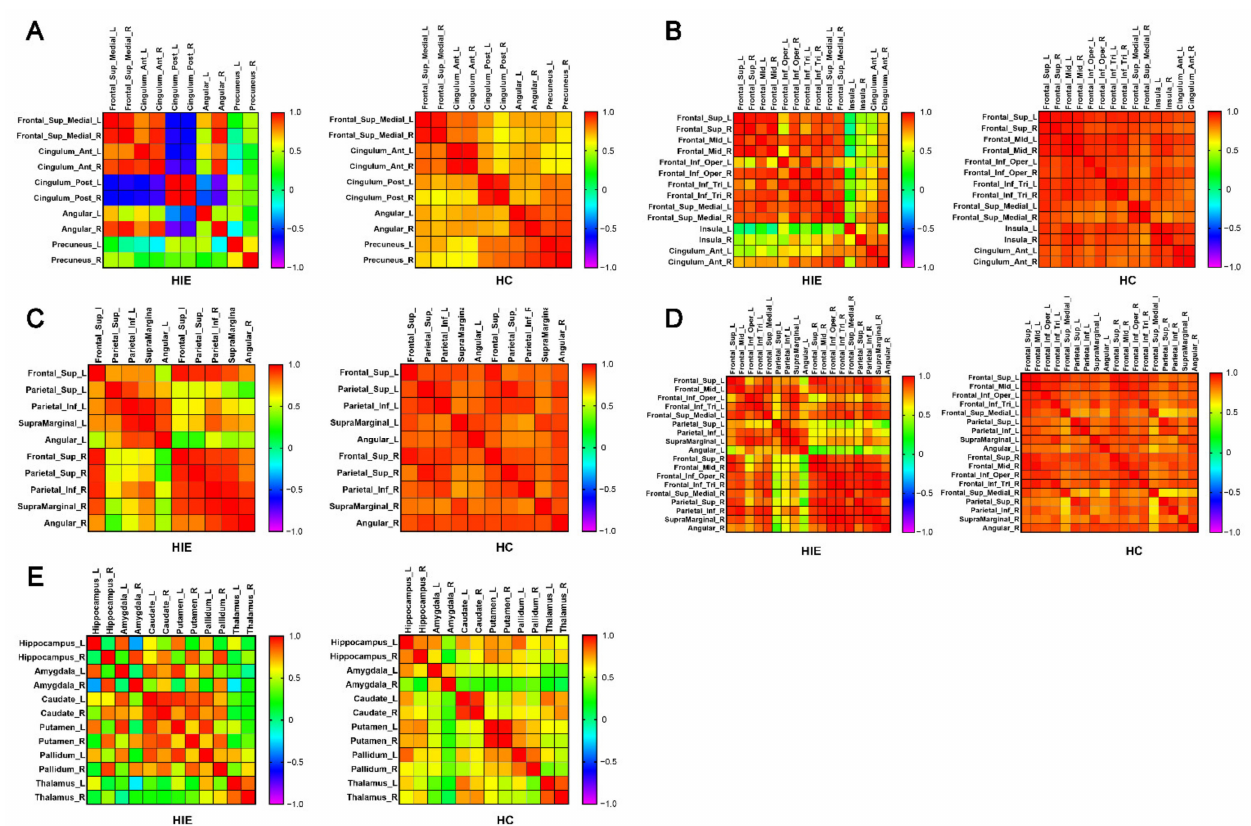
Figure 4. Metabolic connectivity matrix between brain regions associated with different brain networks in the AAL template. ( A ) default mode network (DMN) ( B ) salience network (SN) ( C ) dorsal attention network (DAN) ( D ) executive control network (ECN) ( E ) subcortex network. Colors in the metabolic connectivity matrix represent the magnitude of the correlation and colors are arranged as a rainbow color from red to purple according to the magnitude of the correlation from positive to negative. HIE, hypoxic ischemic encephalopathy. HC, healthy control. L, left. R,